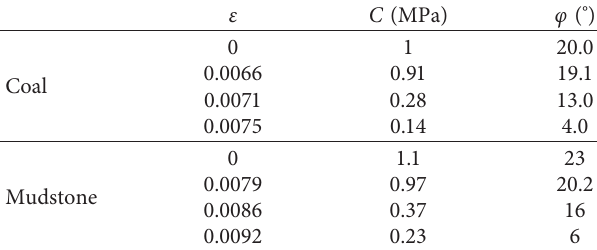
Table 1: Parameters of cohesion and friction angle between coal and mudstone as a function of plastic